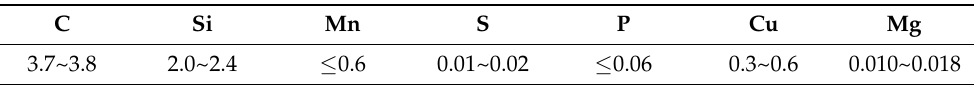
Table 1. Nominal chemical compositions of vermicular graphite cast iron (wt.%).